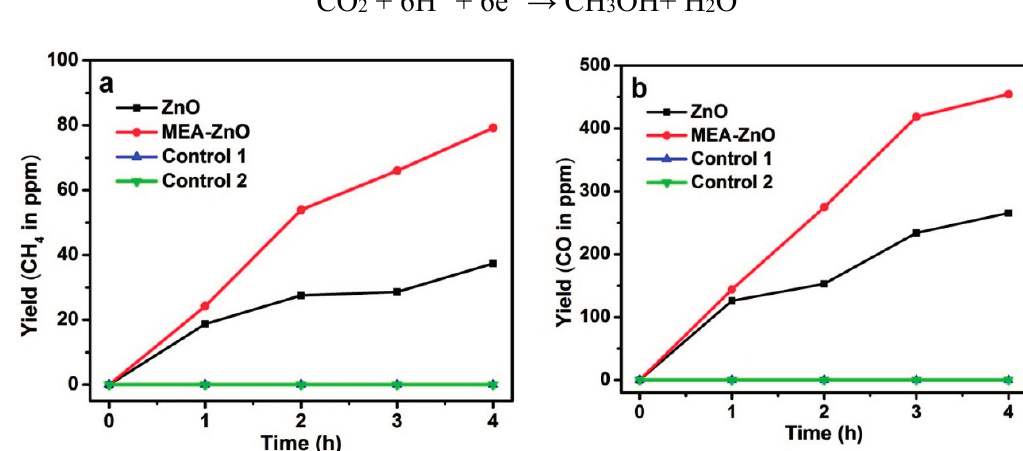
Figure 5. The amount of generated ( a ) CH 4 and ( b ) CO as a function of irradiation time over the sample of MEA–ZnO or clean ZnO. Control experiments without light irradiation (control 1) or without CO 2 (control 2) showed no generation of CO and CH 4 .